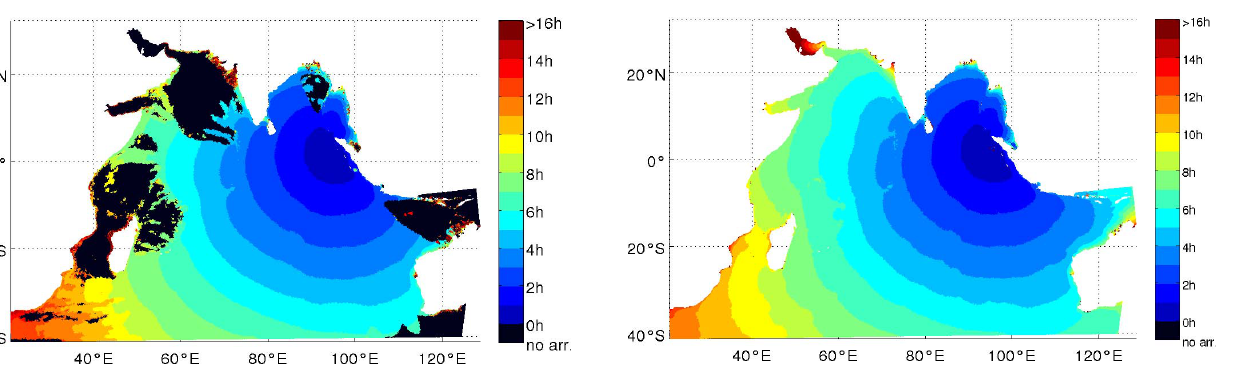
Fig. 2. Arrival time with a threshold of 2cm for a minor tsunami scenario, M w = 8 . 0. In the regions marked in black, the fixed threshold is never reached, at some, it is reached by the second or third wave crest.